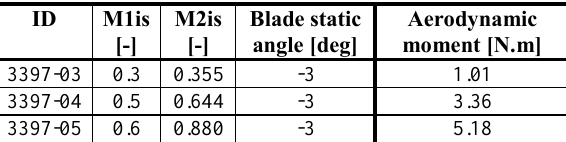
Table 2. Aerodynamic torque on the middle blade measured by strain gauges for three flow regimes.